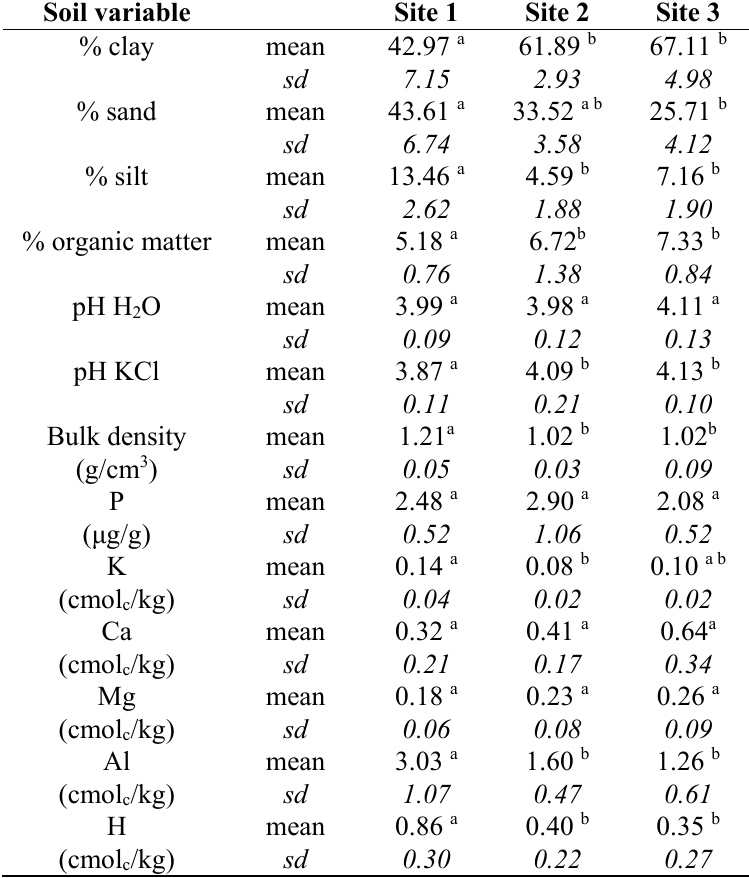
Table A1. For each site, mean and standard deviation ( sd ) of soil % clay, sand, and silt, % organic matter, pH H 2 O, pH KCl, bulk density, and content of P, K, Ca, Mg, Al and H are given. The letters indicate significant differences between